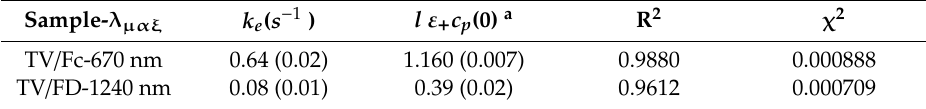
Table 1. Fitting parameters for the coloration kinetics at 670 nm and 1430